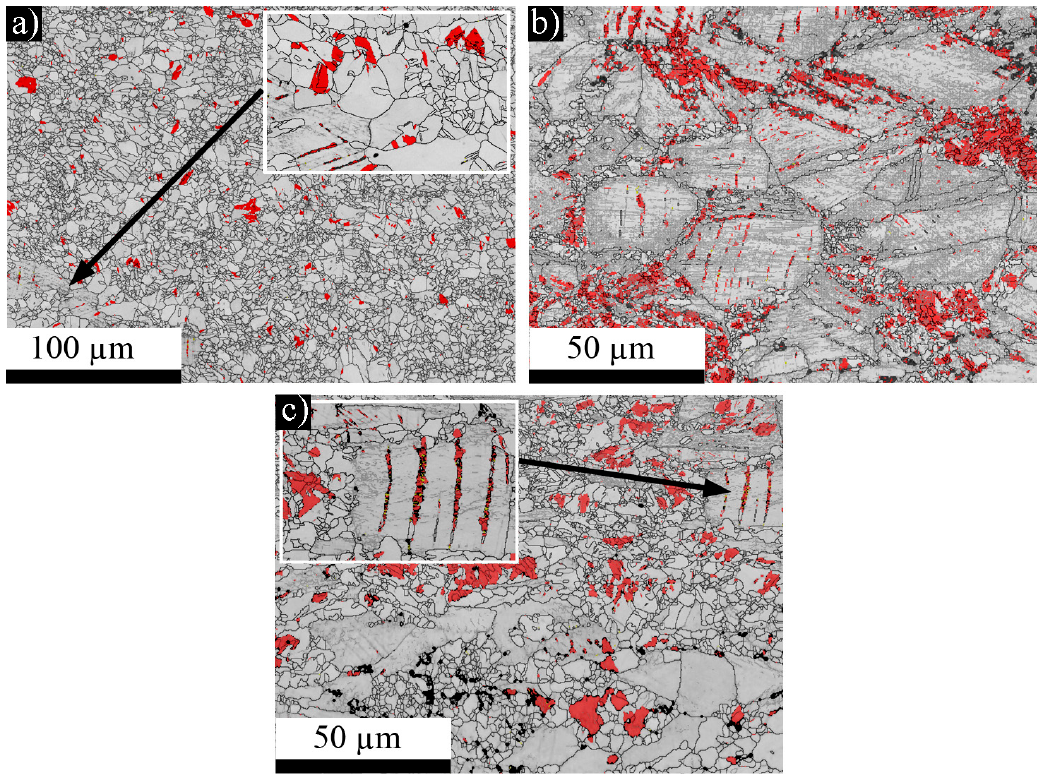
Figure 10. EBSD maps after exposure to 7% tensile strain. DIM (the red colored phase) in medium-sized grains and some shear bands ( a ) 900-1-32CR, ( b ) 750-0.1-32CR, ( c ) 800-10-32CR. Black spots in ( c ) are non-indexed areas.